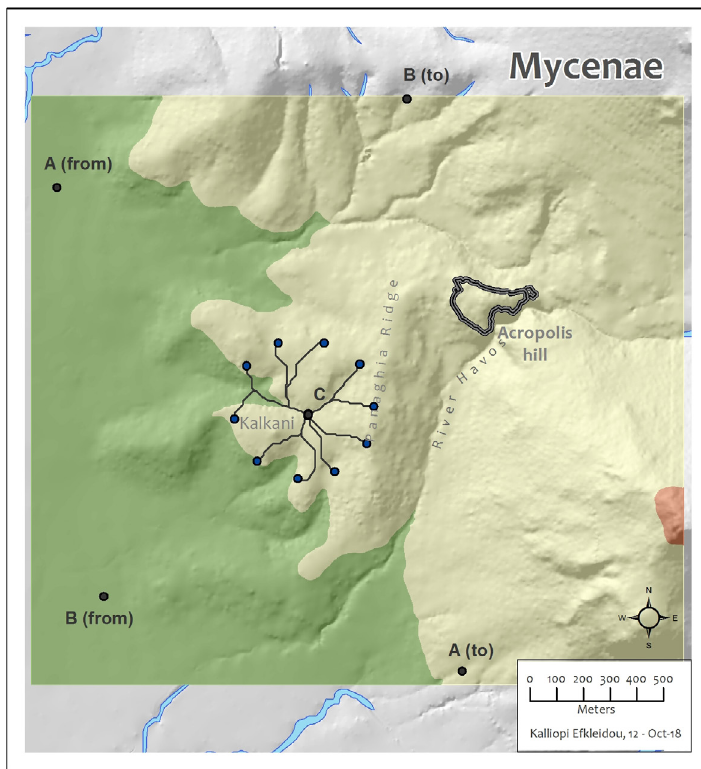
Figure 11. The LCPs based on an 8% critical slope raster originating from point C towards all directions.